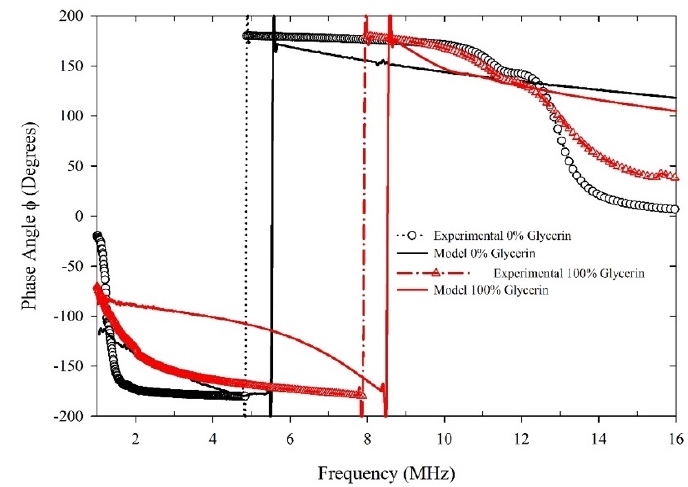
Figure 8. Variation of phase shift with frequency for both experimental and simulated at different concentration of glycerin and water.